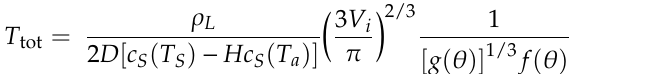
Figure S1: Real-time microscope imaging system for observing water droplet evaporation on the transparent heater surfaces, Figure S2: Photograph of the fabricated ITO / Ag / ITO multilayer transparent heater and uniformity of the measured sheet resistance (4–6 Ω / sq) of the heater, Figure S3: Steady-state temperature of ITO / Ag / ITO multilayer transparent heater according to input voltage and heater size, Figure S4: Reproducibility of heat-generation performance of the ITO / Ag / ITO multilayer transparent heater for 30 days, Figure S5: IR images without any contacts underneath the heater. Figure S6: Images captured by the webcam (a) without and (b) with the transparent heater, and (c) during operation at 50 ◦ C, Figure S7: Defrosting test results using a transparent heater, Figure S8: Water droplet evaporation on the surfaces of the ITO / Ag / ITO multilayer transparent heaters (heat-generation temperature of 30 ◦ C) with di ff erent wetting properties, Figure S9: Water droplet evaporation on the surfaces of the ITO / Ag / ITO multilayer transparent heaters (heat-generation temperature of 45 ◦ C) with di ff erent wetting properties, Figure S10: Water droplet evaporation on the surfaces of the ITO / Ag / ITO multilayer transparent heaters (heat-generation temperature of 65 ◦ C) with di ff erent wetting